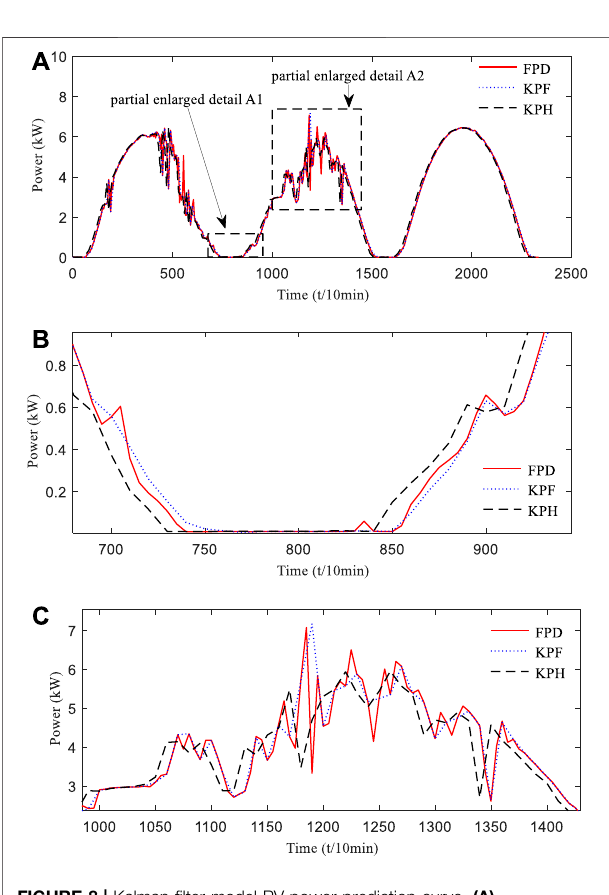
FIGURE 8 | Kalman fi lter model PV power prediction curve. (A) Photovoltaic power prediction curve in forecasting days; (B) Photovoltaic power prediction curve in insuf fi cient illumination; (C) Photovoltaic power prediction curve in suf fi cient illumination.